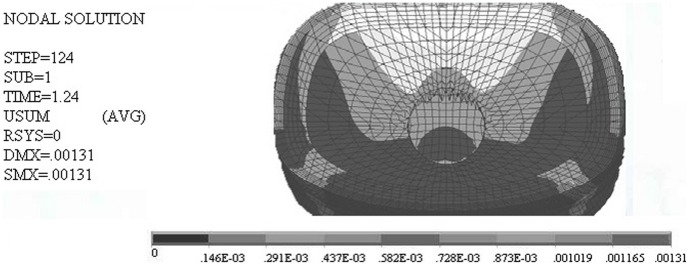
Contour of finger deformation.